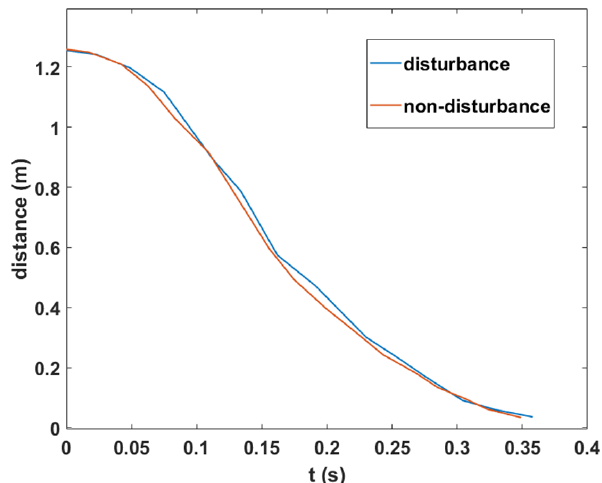
Figure 11. The distance to the target